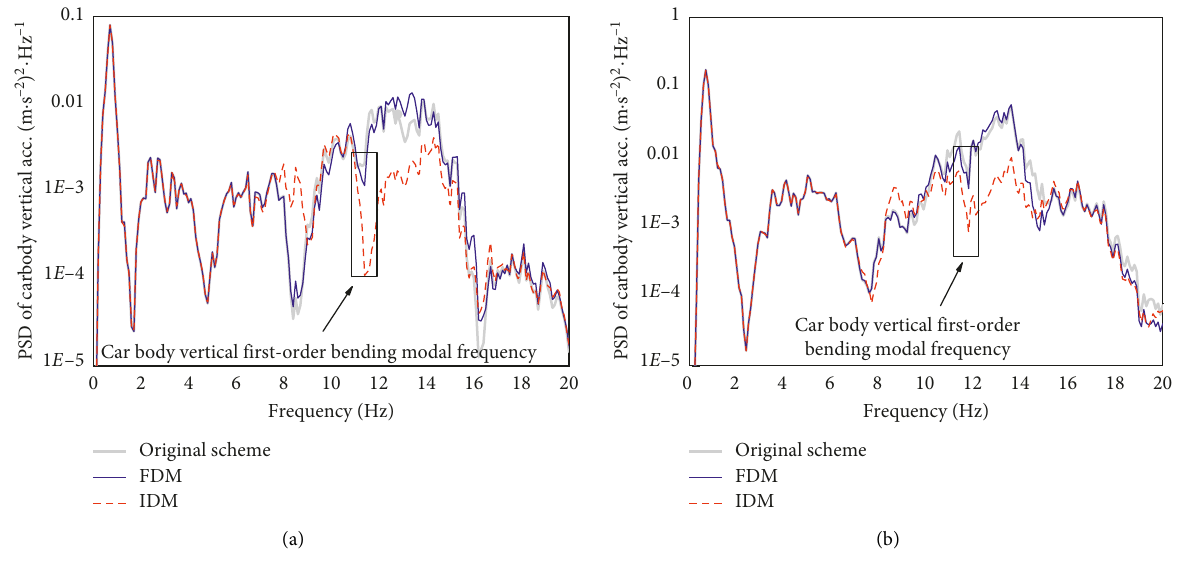
Figure 12: The power spectrum of car body vertical vibration acceleration. (a) The speed of 200km/h. (b) The speed of 300 km/h.